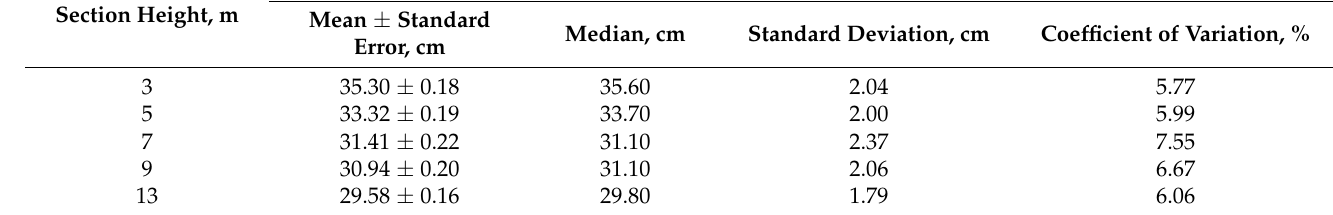
Table 4. Descriptive statistics of the upper-stem diameters measured with a laser caliper after the exclusion of the abnormal data sets.